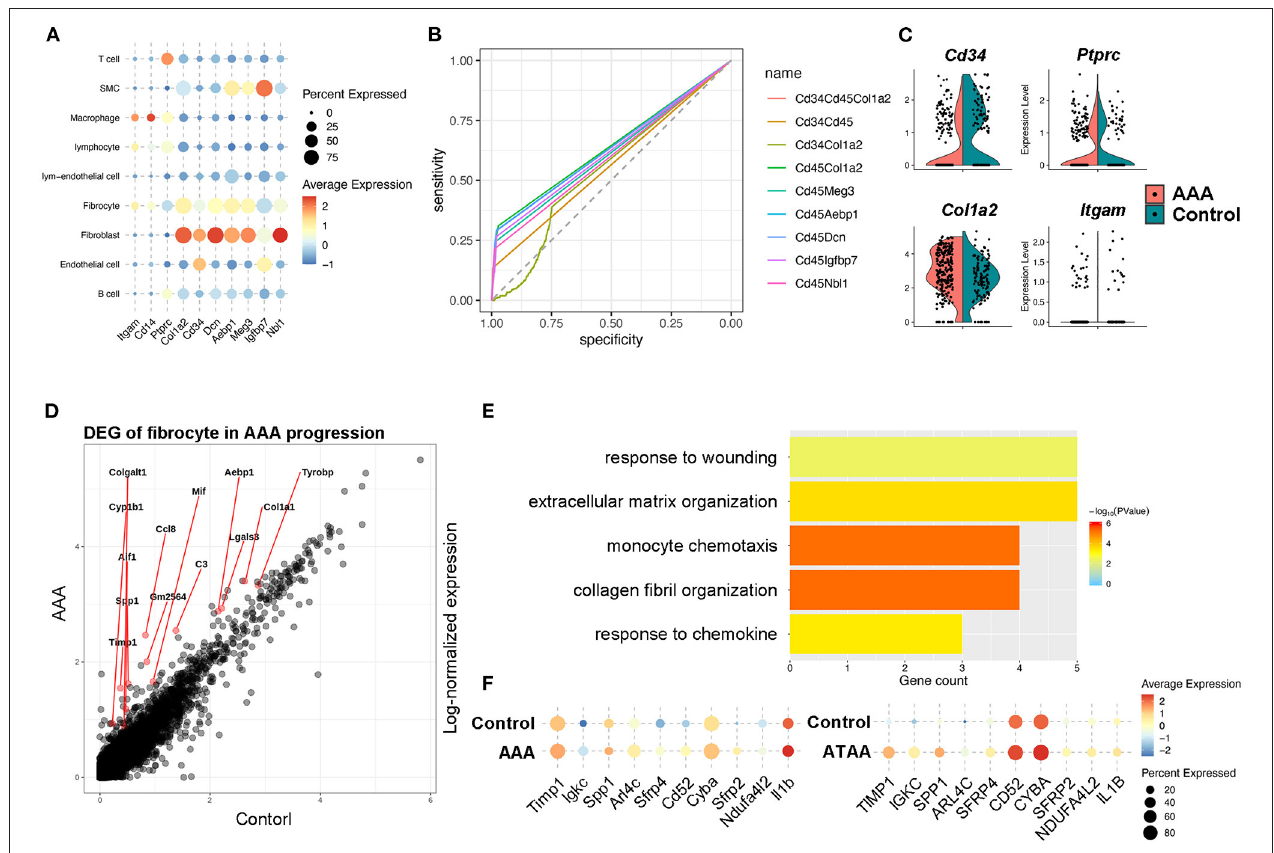
FIGURE 4 | Identification and function of fibrocytes in AAA pathogenesis. (A) Dot plot showing the expression of classic fibrocyte markers and the top 5 highly expressed genes compared with macrophages. (B) The ROC curve identifying the sensitivity and specificity of the co-expression of distinct marker genes. (C) Violin plots of the expression levels of the classic marker genes that identify fibrocytes during Ang II infusion. (D) Differentially expressed genes (DEGs) of fibrocytes during Ang II infusion. (E) Bar plot of Gene Ontology (GO) pathway enrichment of DEGs in fibrocytes. (F) Dot plot showing the expression of 10 shared DEGs in Ang II model and human